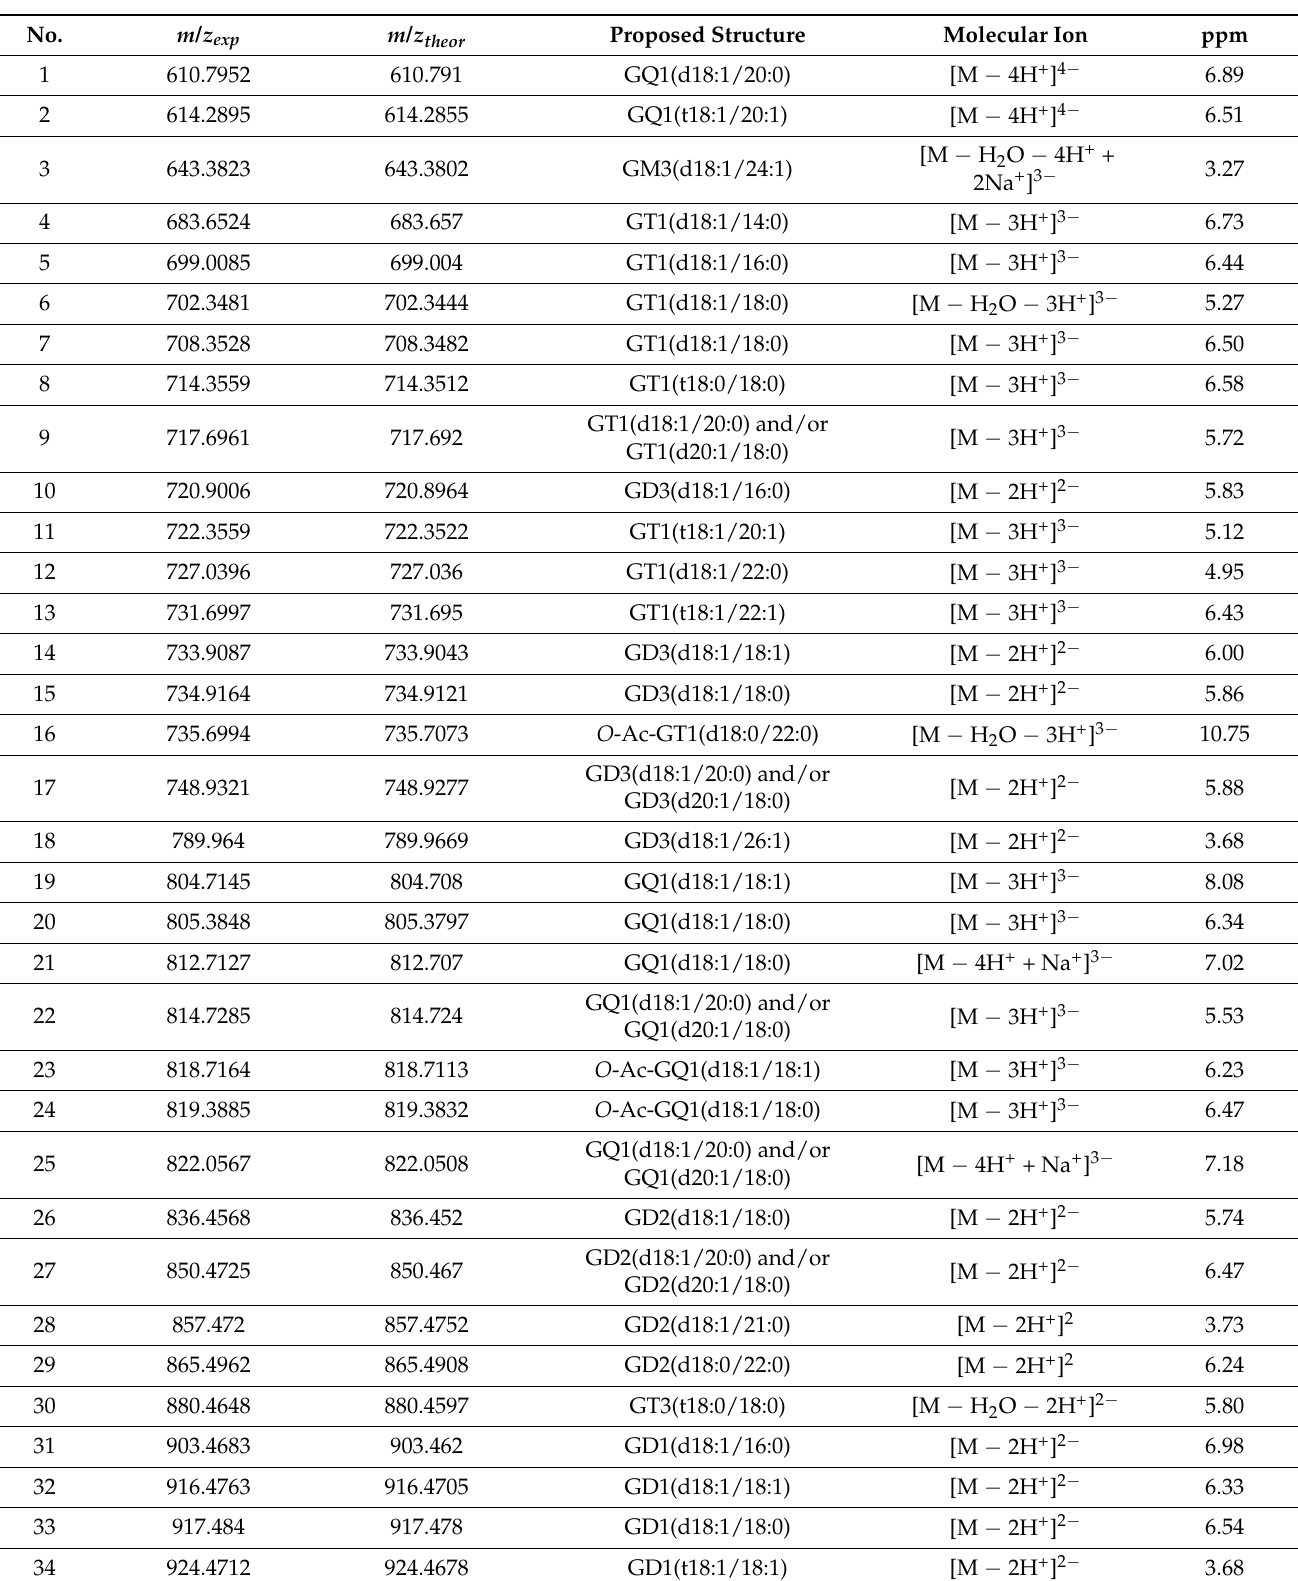
Table 2. The assignment of the ions detected in the spectrum in Figure 3 and the ganglioside